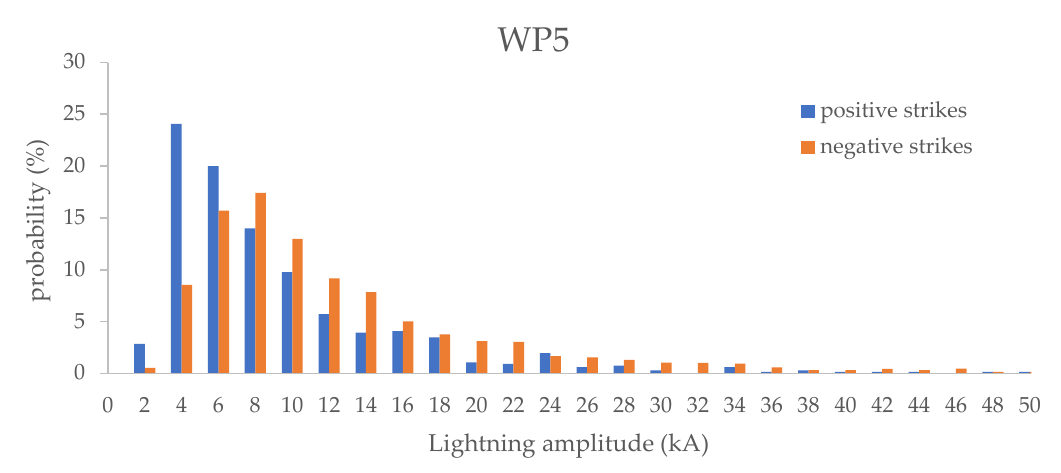
Figure A5. Lightning current amplitude probability distributions for positive and negative strikes extracted from the recorded incidents throughout the period 2011–2020 for WP5.